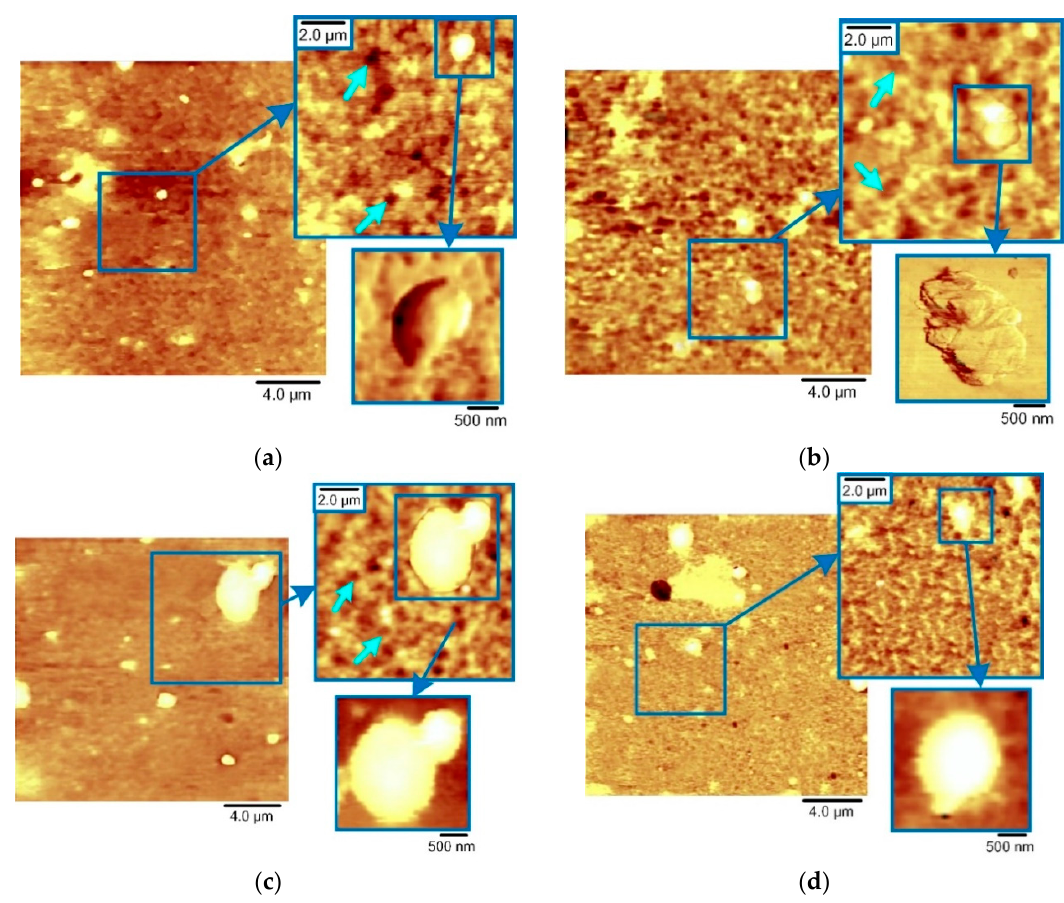
Figure 5. Two-dimensional AFM images of the CrON coatings, area 20 × 20 µm 2 : ( a ) CrN; ( b ) CrO(5)N; ( c ) CrO(20)N; ( d ) CrO(50)N.